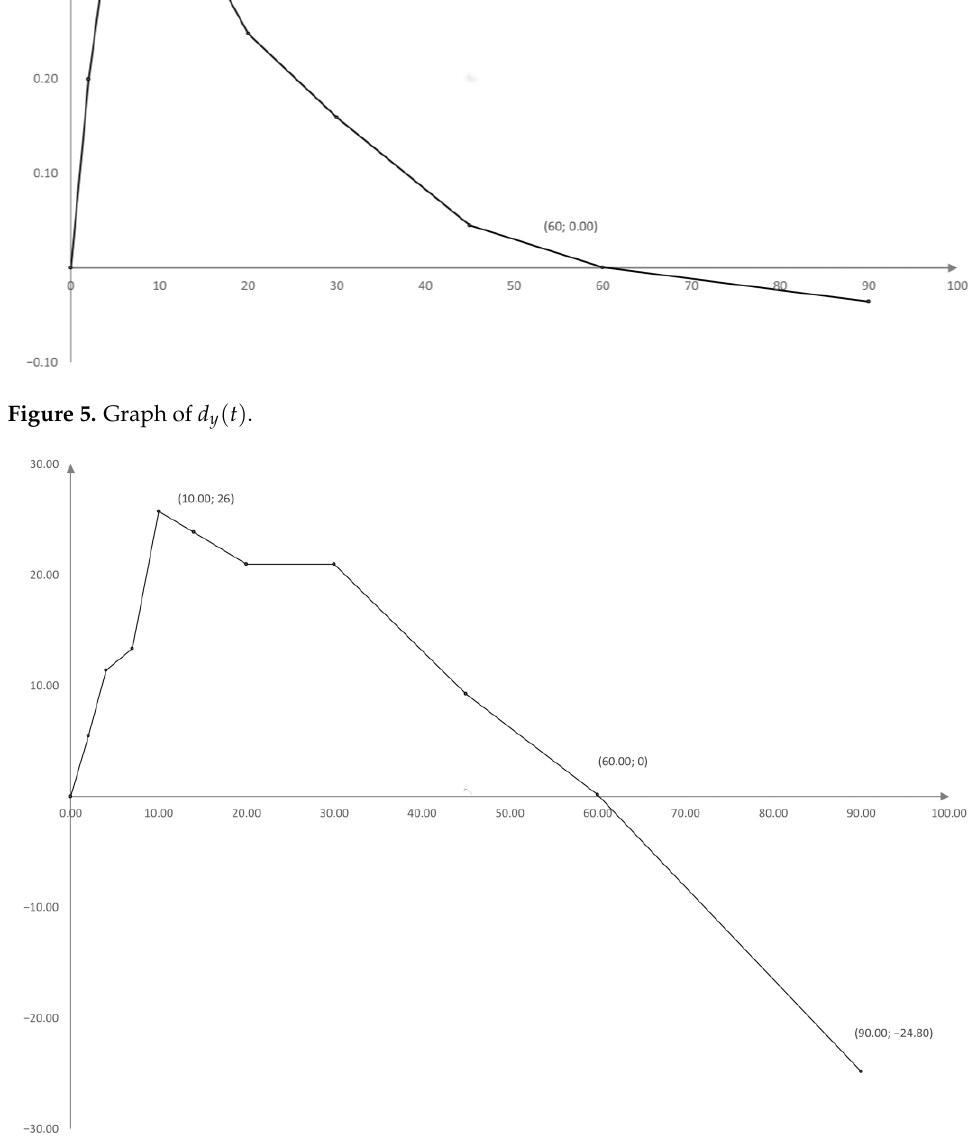
( t ) . (cid:101) t and I y [ t for [ 0, 10 ] and [ 10, 90 ] i , t j ] i , t j ]